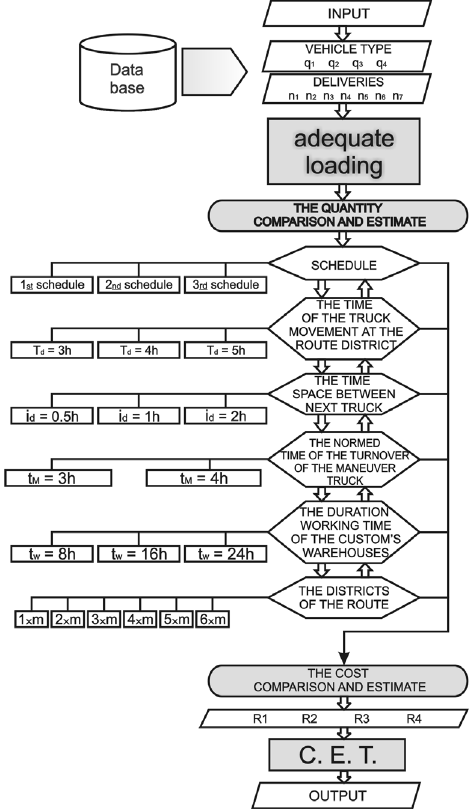
Fig 6. Economic-mathematical model for the choice of cost-effective truck (C. E.